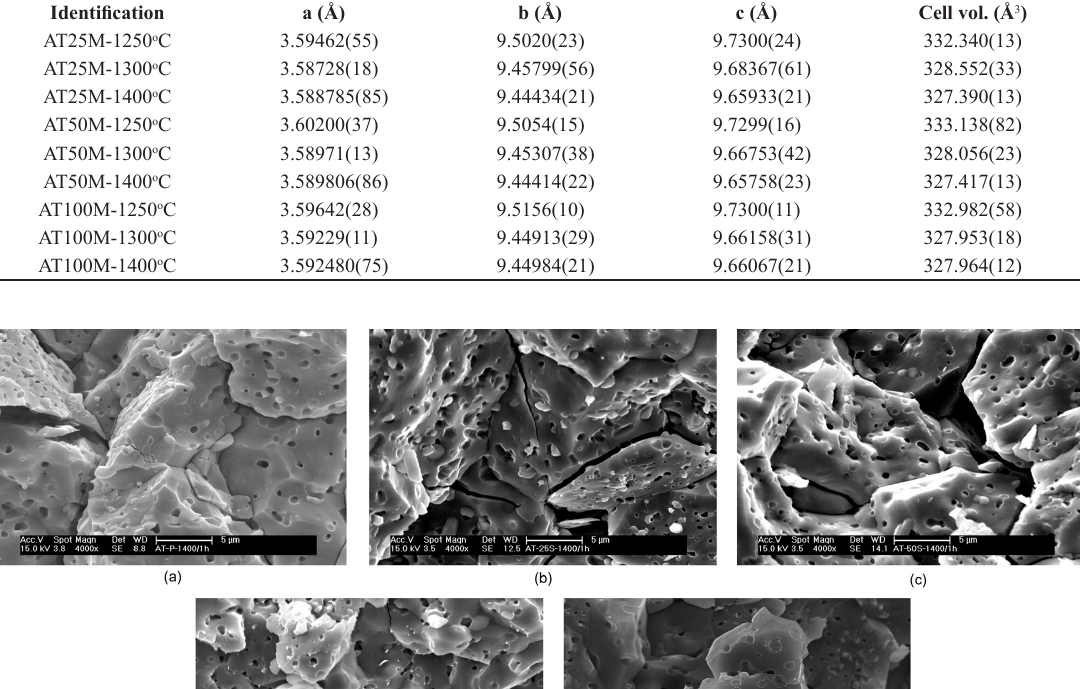
Table 2. Al TiO lattice parameters obtained by Rietveld refinements. 2 5